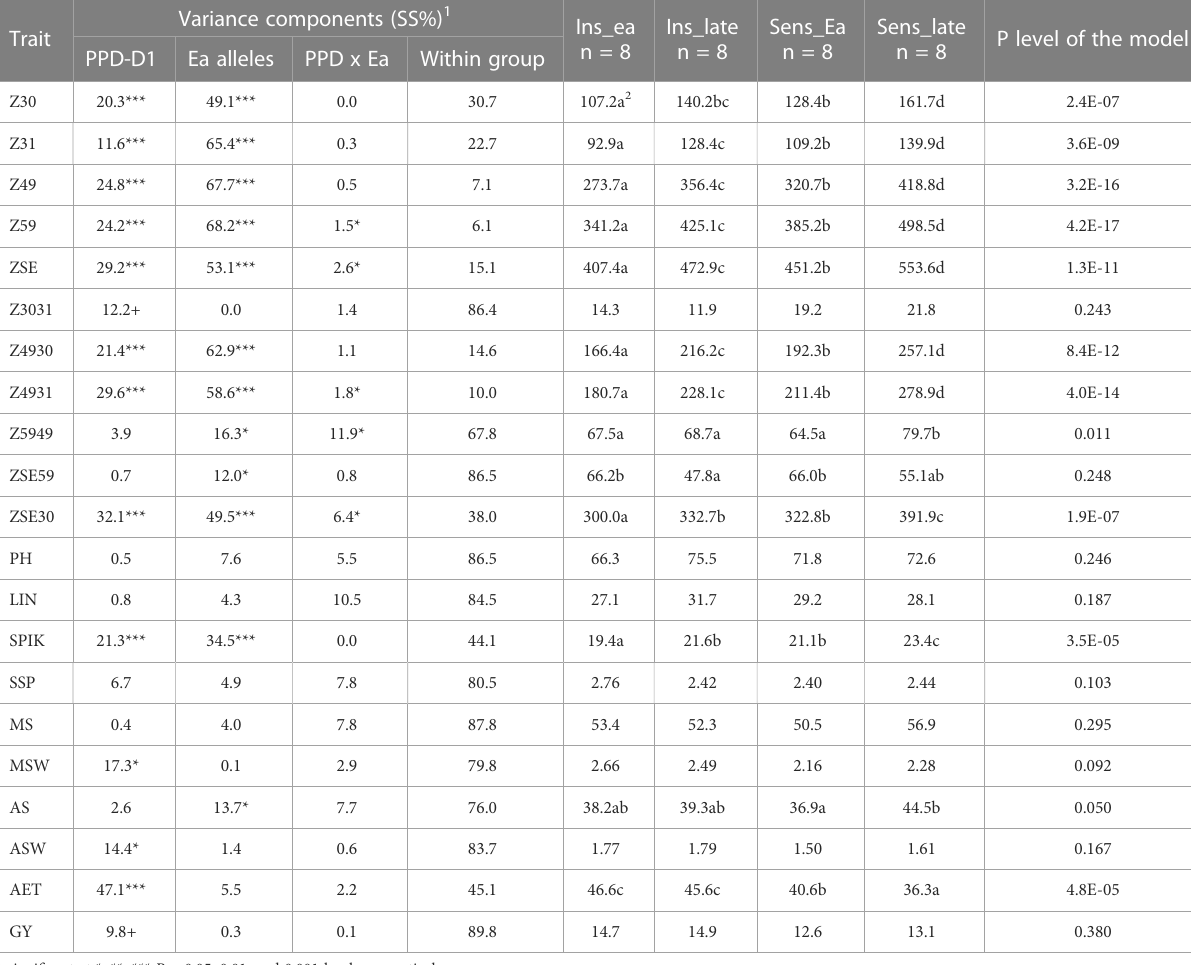
TABLE 2 Descriptive statistics of plant developmental, morphological and yield-related traits and the group averages in 32 winter wheat genotypes representing the early and late groups within each allele phase of PPD-D1 .